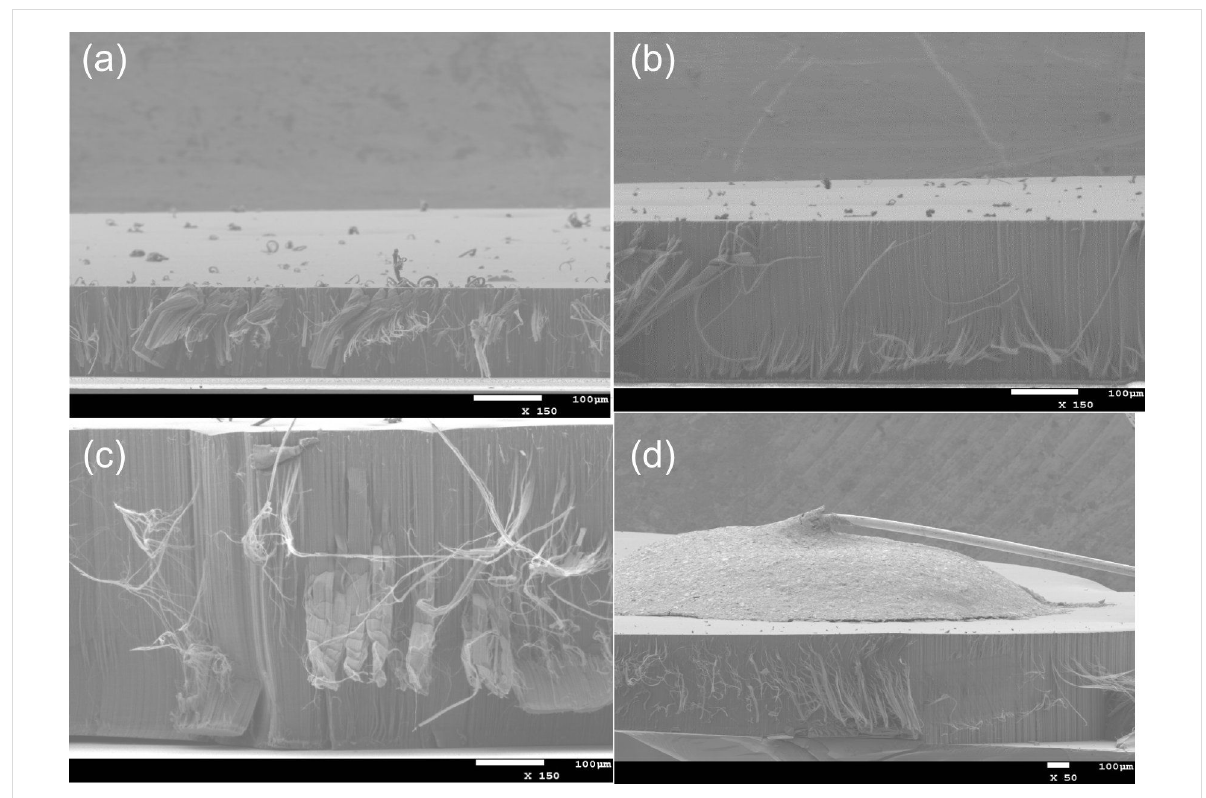
Figure 1: FE-SEM images of sensor devices made of VA-CNTs decorated with gold nanoparticles with different CNT lengths of (a) 150 µm, (b) 300 µm, (c) 510 µm and (d) image of a silver electrode drop casted on top of the device.